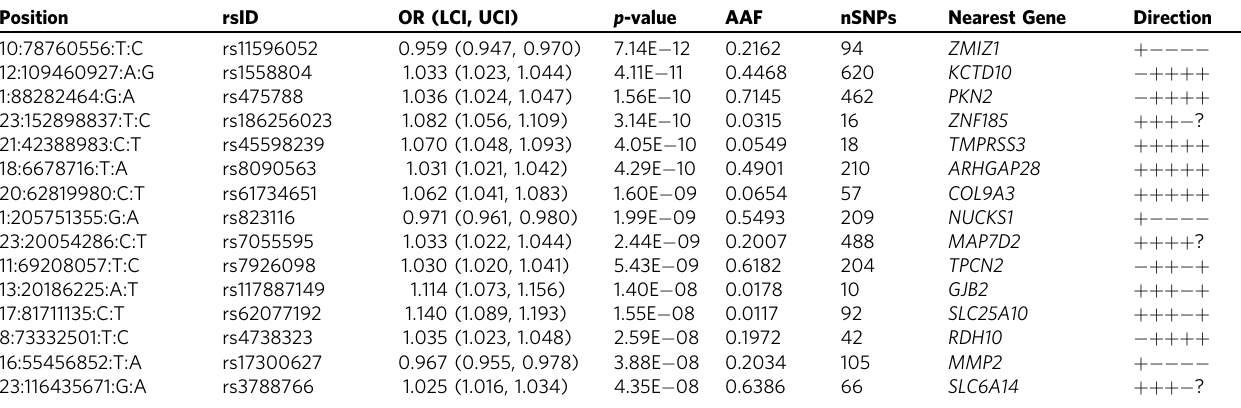
Table 1 Lead variants at the 15 loci not previously reported to be associated with hearing loss in